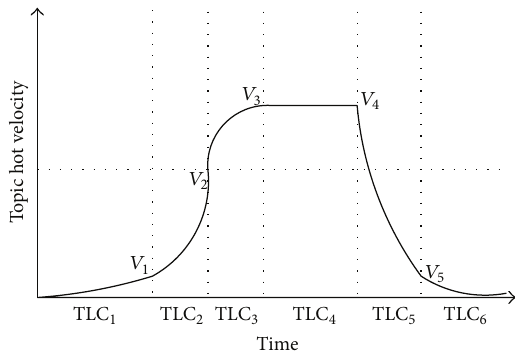
Figure 3: Topic life cycle illustrated with the topic hot